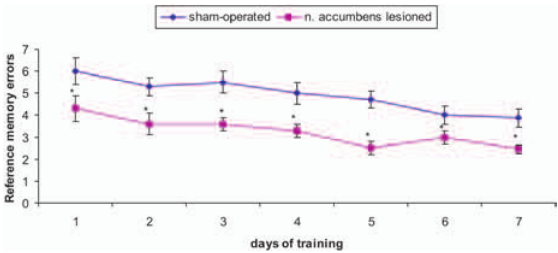
Figure 1. The number of reference memory errors in the rats with 6-OHDA-induced lesion of the NAcc, as studied in the radial-arm-maze task. The values are mean ± SEM (n=6 animals per group). *p<0.05 vs. sham-operated